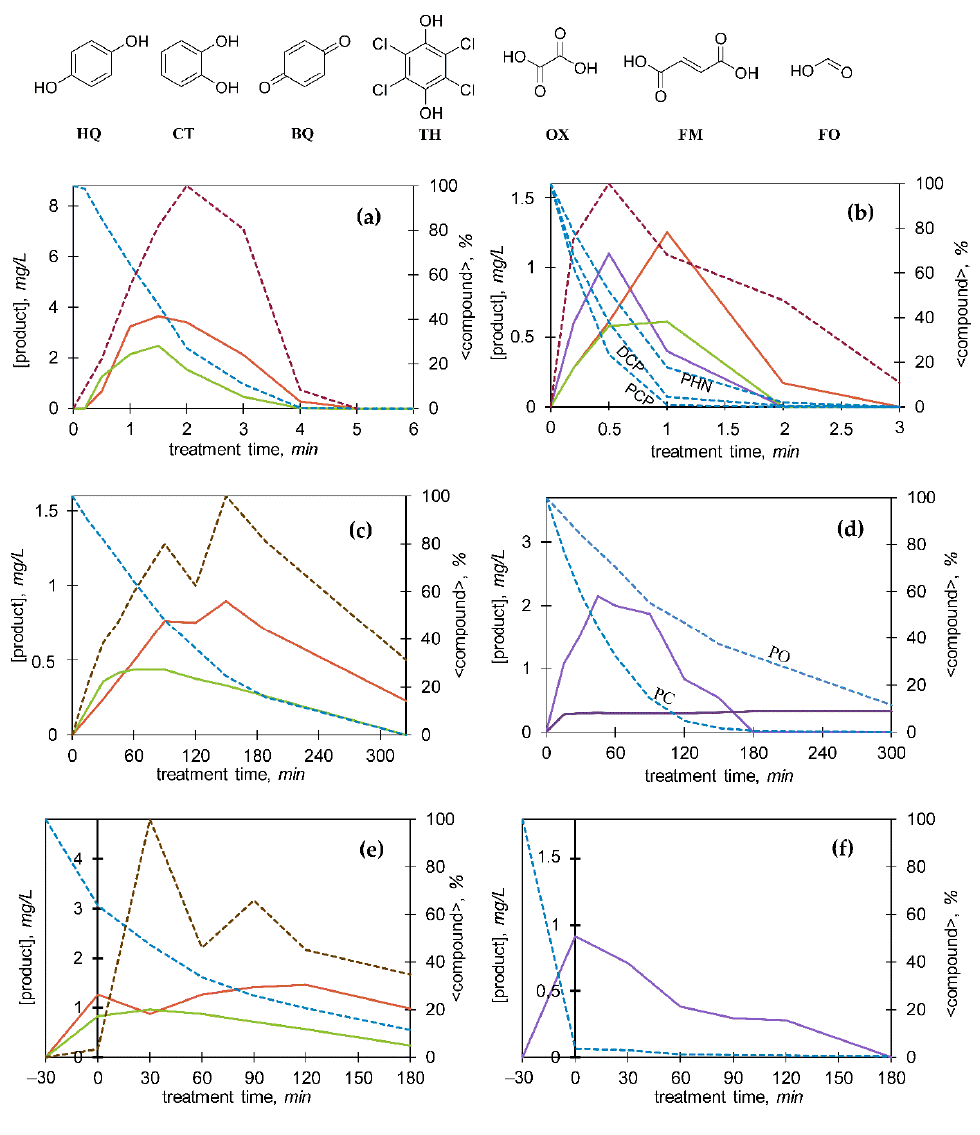
Figure 5. Concentrations (left y -axis) of hydroquinone (HQ), catechol (CT), and tetrachlorohydroquinone (TH), and normalized relative amount (right y -axis; see Equation (4) in Section 2.4) of parent phenols (PHN, DCP, PCP) and p -benzoquinone (BQ) during ( a ) ozonation of phenol (PHN) (50 mg/L); ( b ) ozonation of mixture (10 mg/L each); ( c ) photocatalysis of PHN (10 mg/L); ( d ) photocatalysis and photooxidation of pentachlorophenol (PCP) (10 mg/L); ( e ) sequential method of PHN (approximately 20 mg/L); ( f ) sequential method of PCP (approximately 10 mg/L).